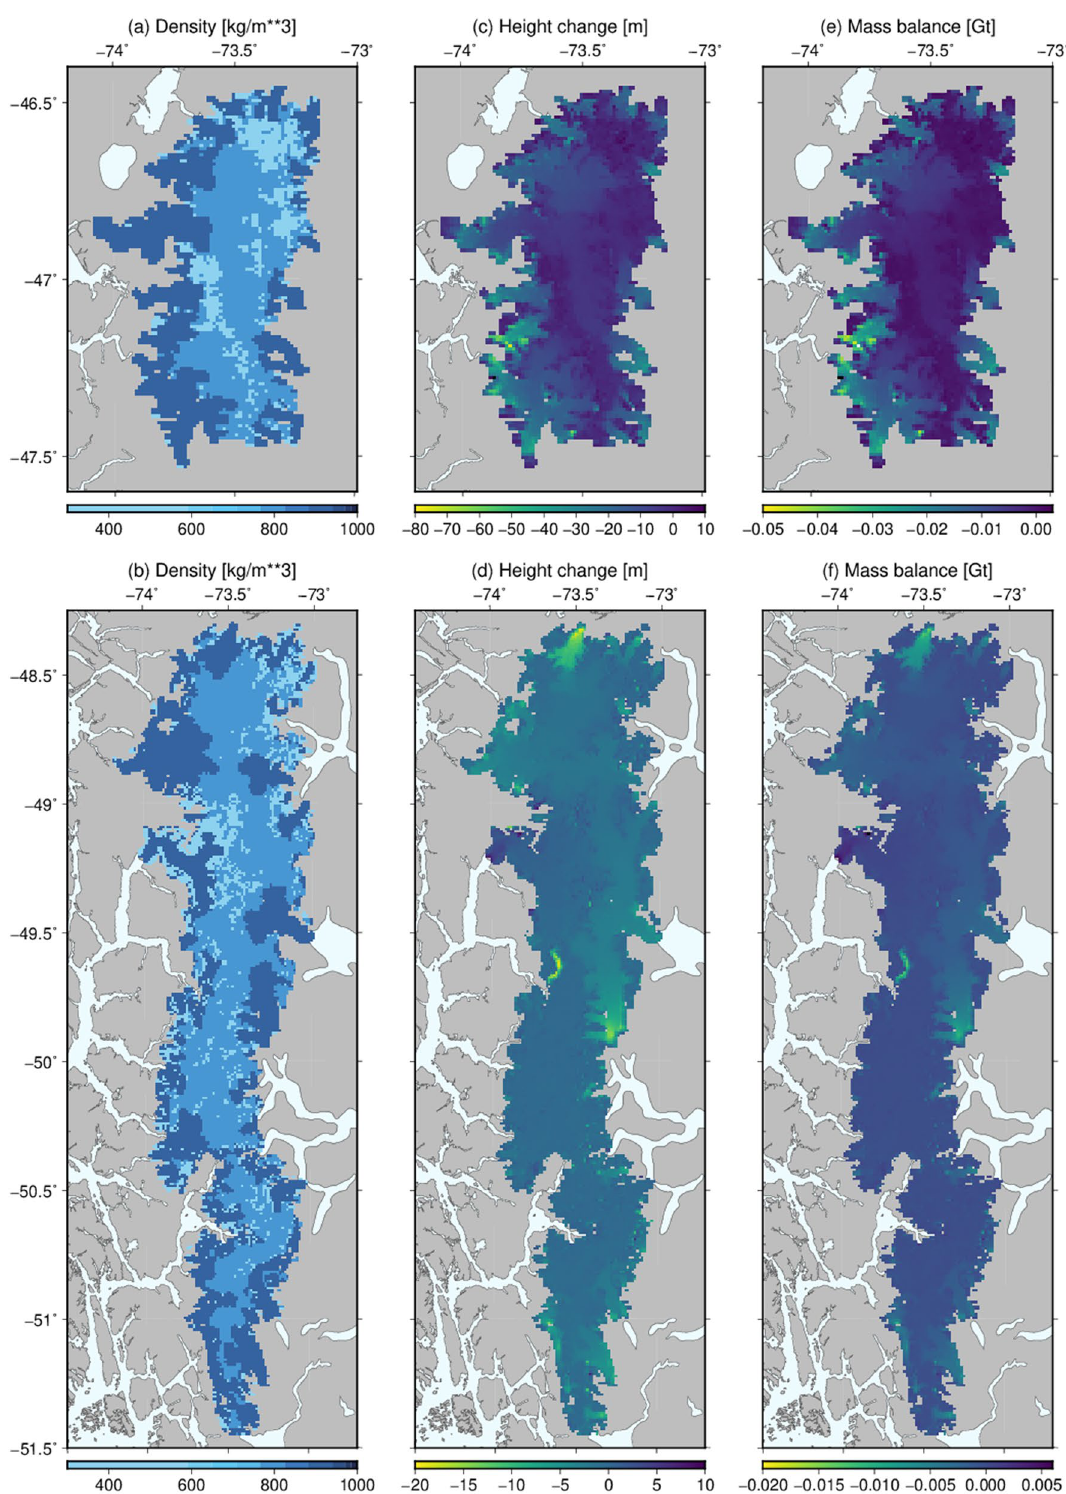
Figure 3. Results for model C (maps created using the Generic Mapping Tools 37 version 6, https:// docs. gener ic- mappi ng- tools. org/6. 0/). Disk densities for NPIF ( a ) and SPIF ( b ). Height changes after multiplying the dh/dt grids by Δt for NPIF ( c ) and SPIF ( d ). Mass balance grid for NPIF ( e ) and SPIF ( f ) using the estimated densities from ( a ) and ( b ) and the height change from ( c ) and ( d